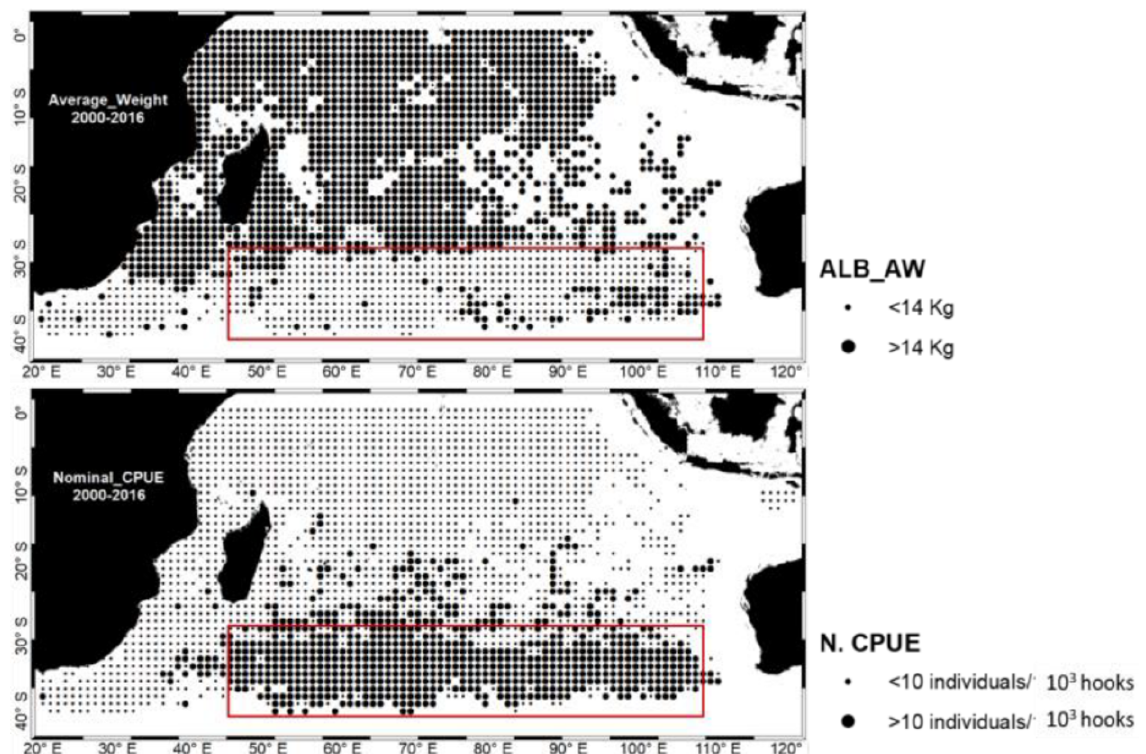
Figure 1. Nominal (N) CPUE and average weight (AW) distribution of albacore tuna for the southern Indian Ocean from 2000 to 2016. The area in the red rectangle is the main habitat zone of immature albacore